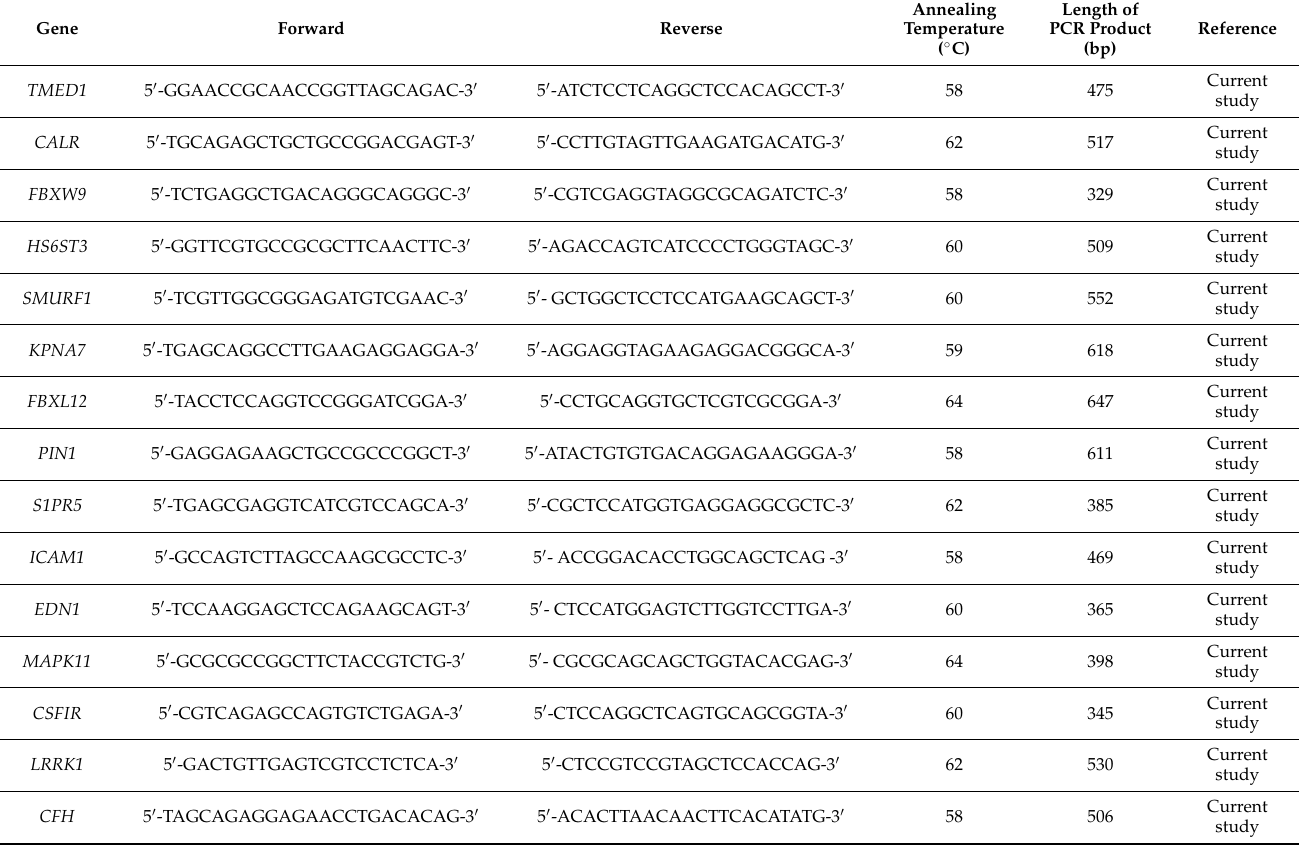
Table 1. Oligonucleotide primers sequence investigated genes utilized in PCR-DNA